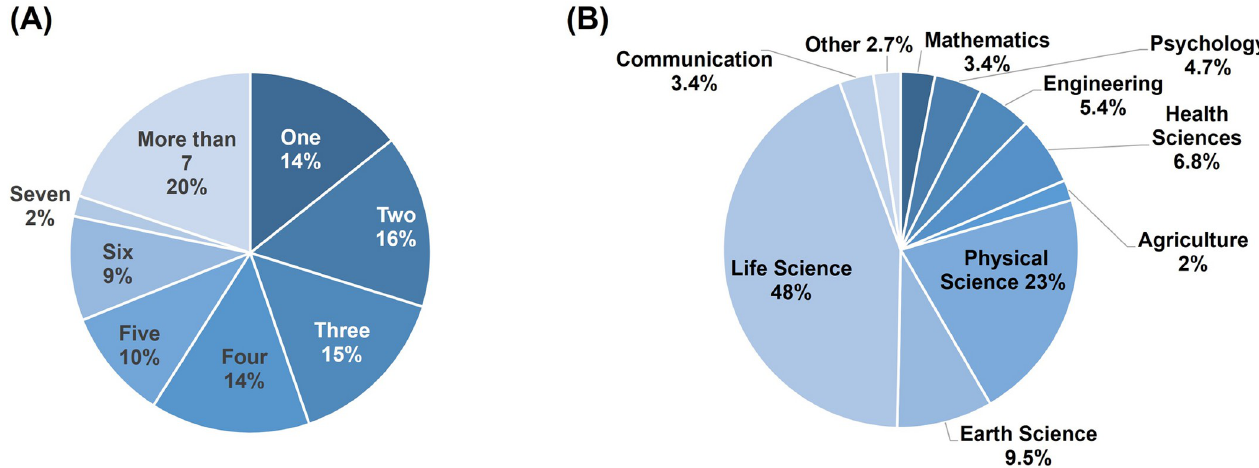
Fig 1. A full list of represented institutions can found in S1 File (S1 Table). A. Participants time completed in graduate school, in years, shown as percent responding. B. Participants subject-specific disciplines binned based on their branch of science following an existing organizational chart (https://www.